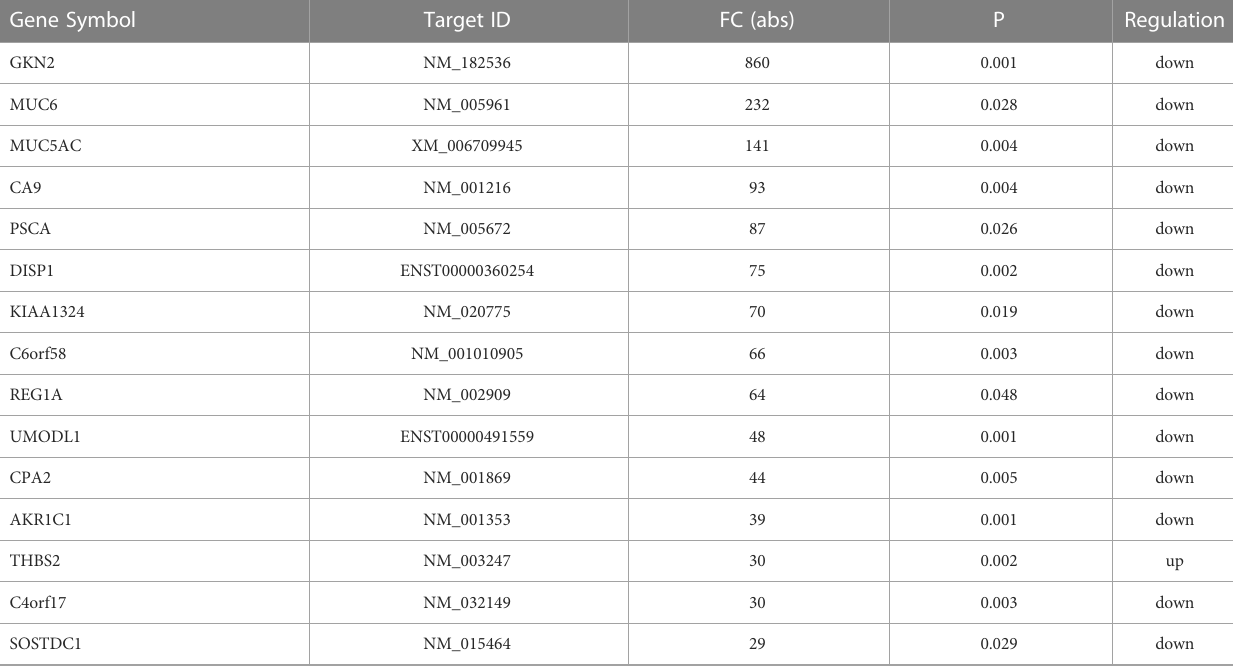
TABLE 2 Top 20 dysregulated mRNA between gastric cancer with and without lymph node